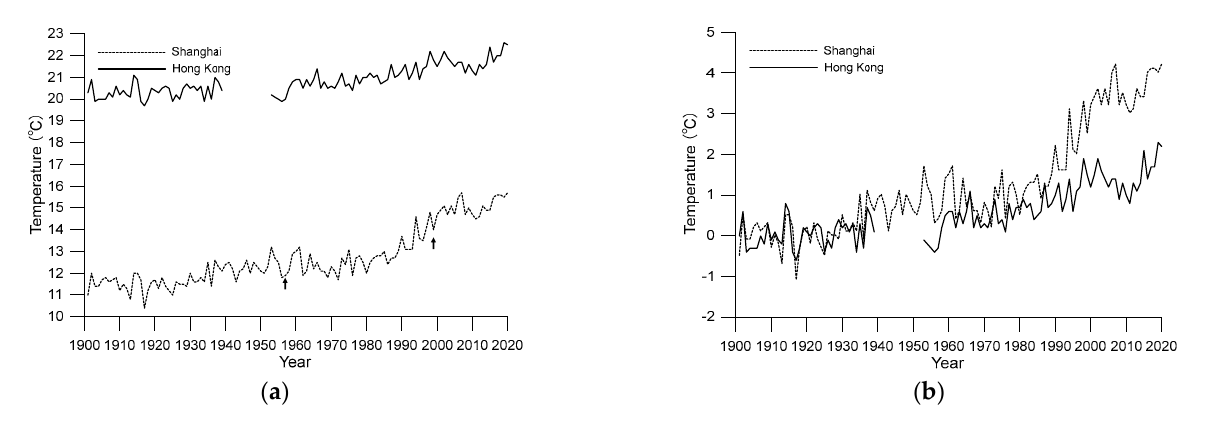
Figure 6. Annual average minimum temperature range from 1901 to 2020 for the Shanghai and Hong Kong observatories (( a ) original observations; ( b ) anomalies to the average values during 1901–1930).